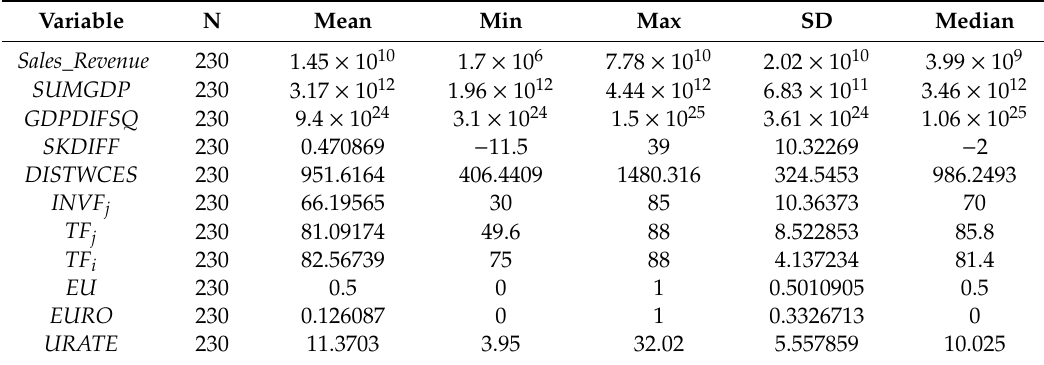
Table A1. Summary